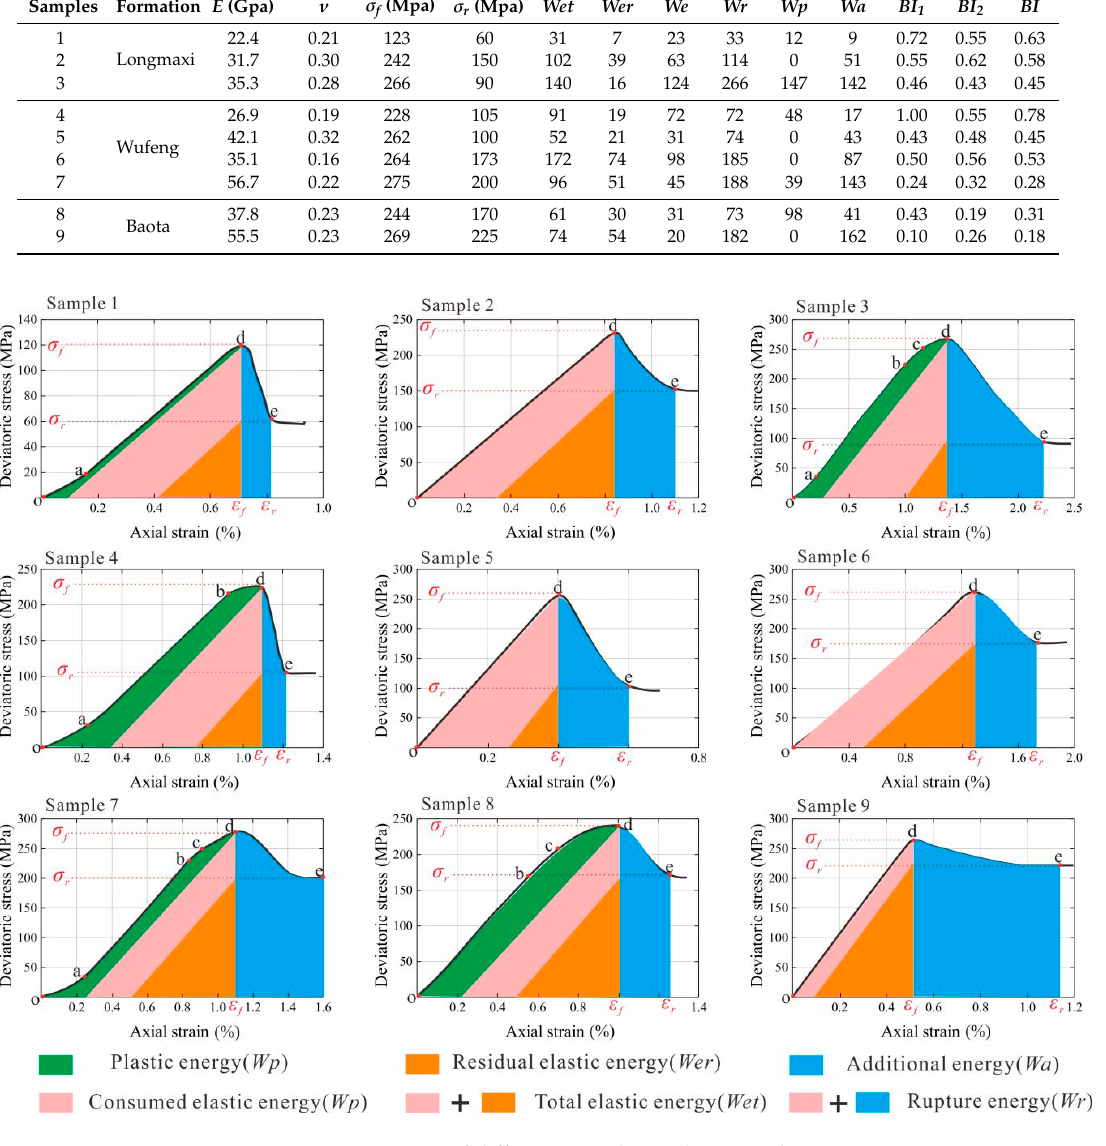
Figure 4. Stress-strain curves of different samples under triaxial compression. Table 2. Summary of mechanical parameters obtained from complete stress-strain curves of tested